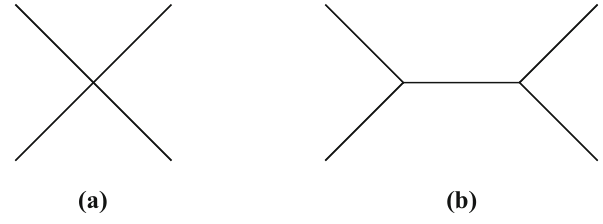
Fig. 1 Tree-level Feynman diagrams for the vector-vector scattering. The u -and t